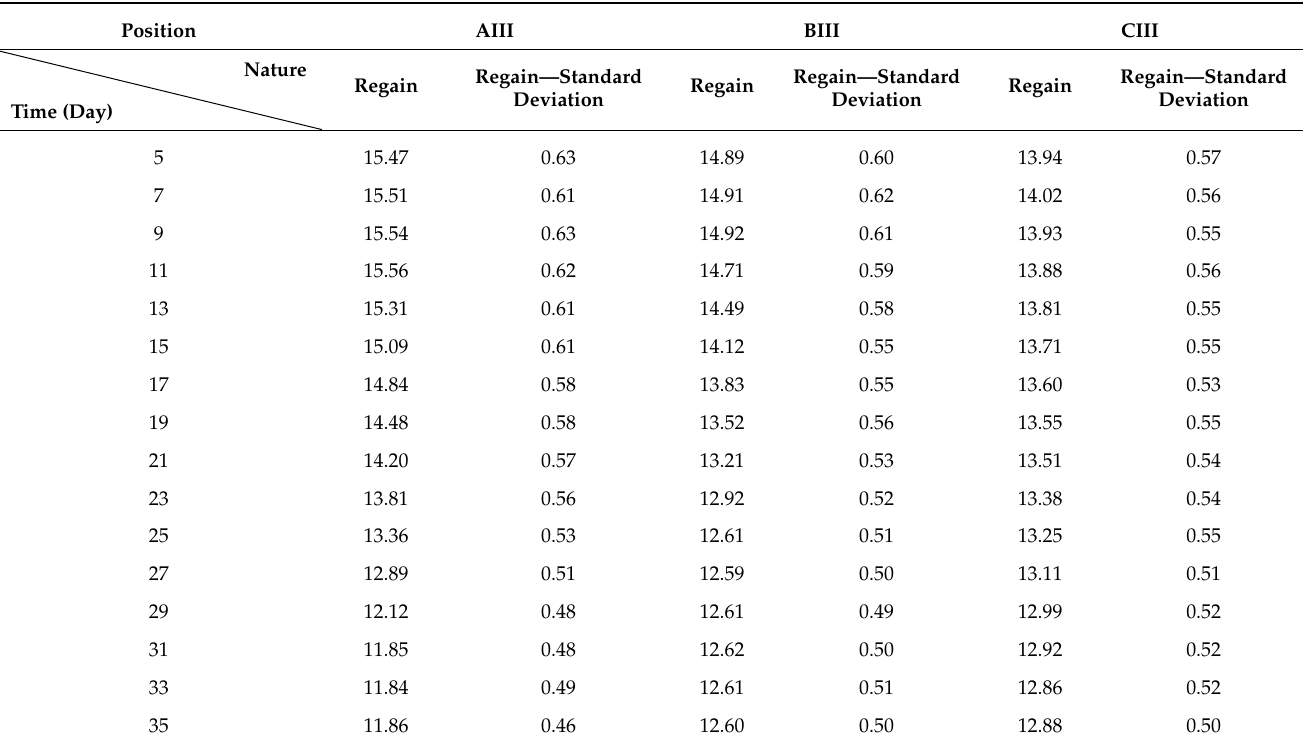
Table 3. Retting duration and fibre moisture regain of outer